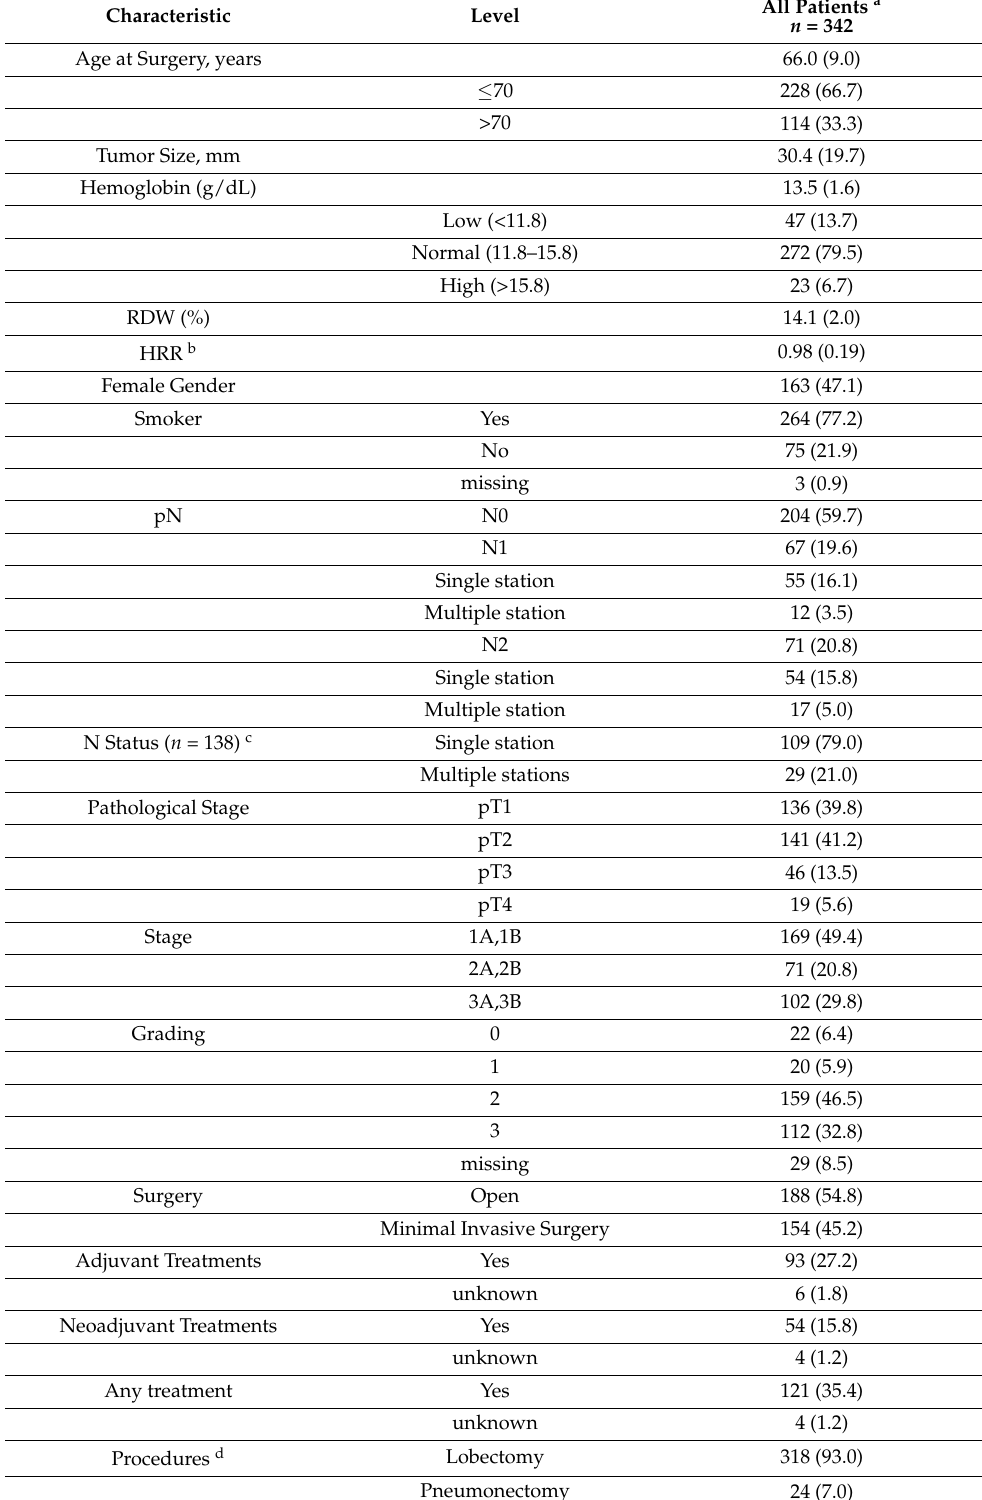
Table 1. Patients’ characteristics and